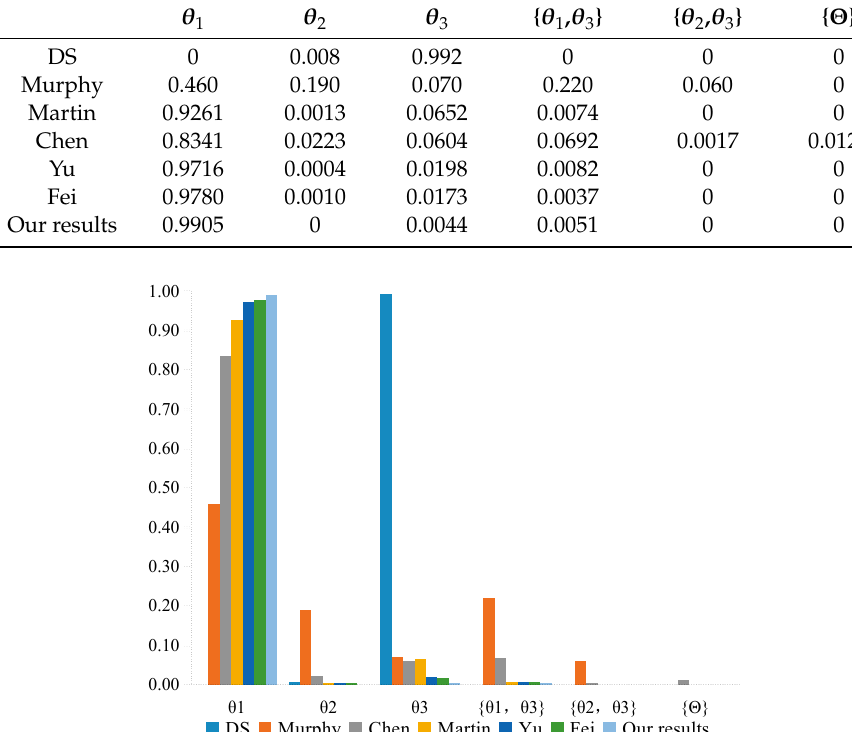
Figure 5. The comparison of the fusion results in different methods.